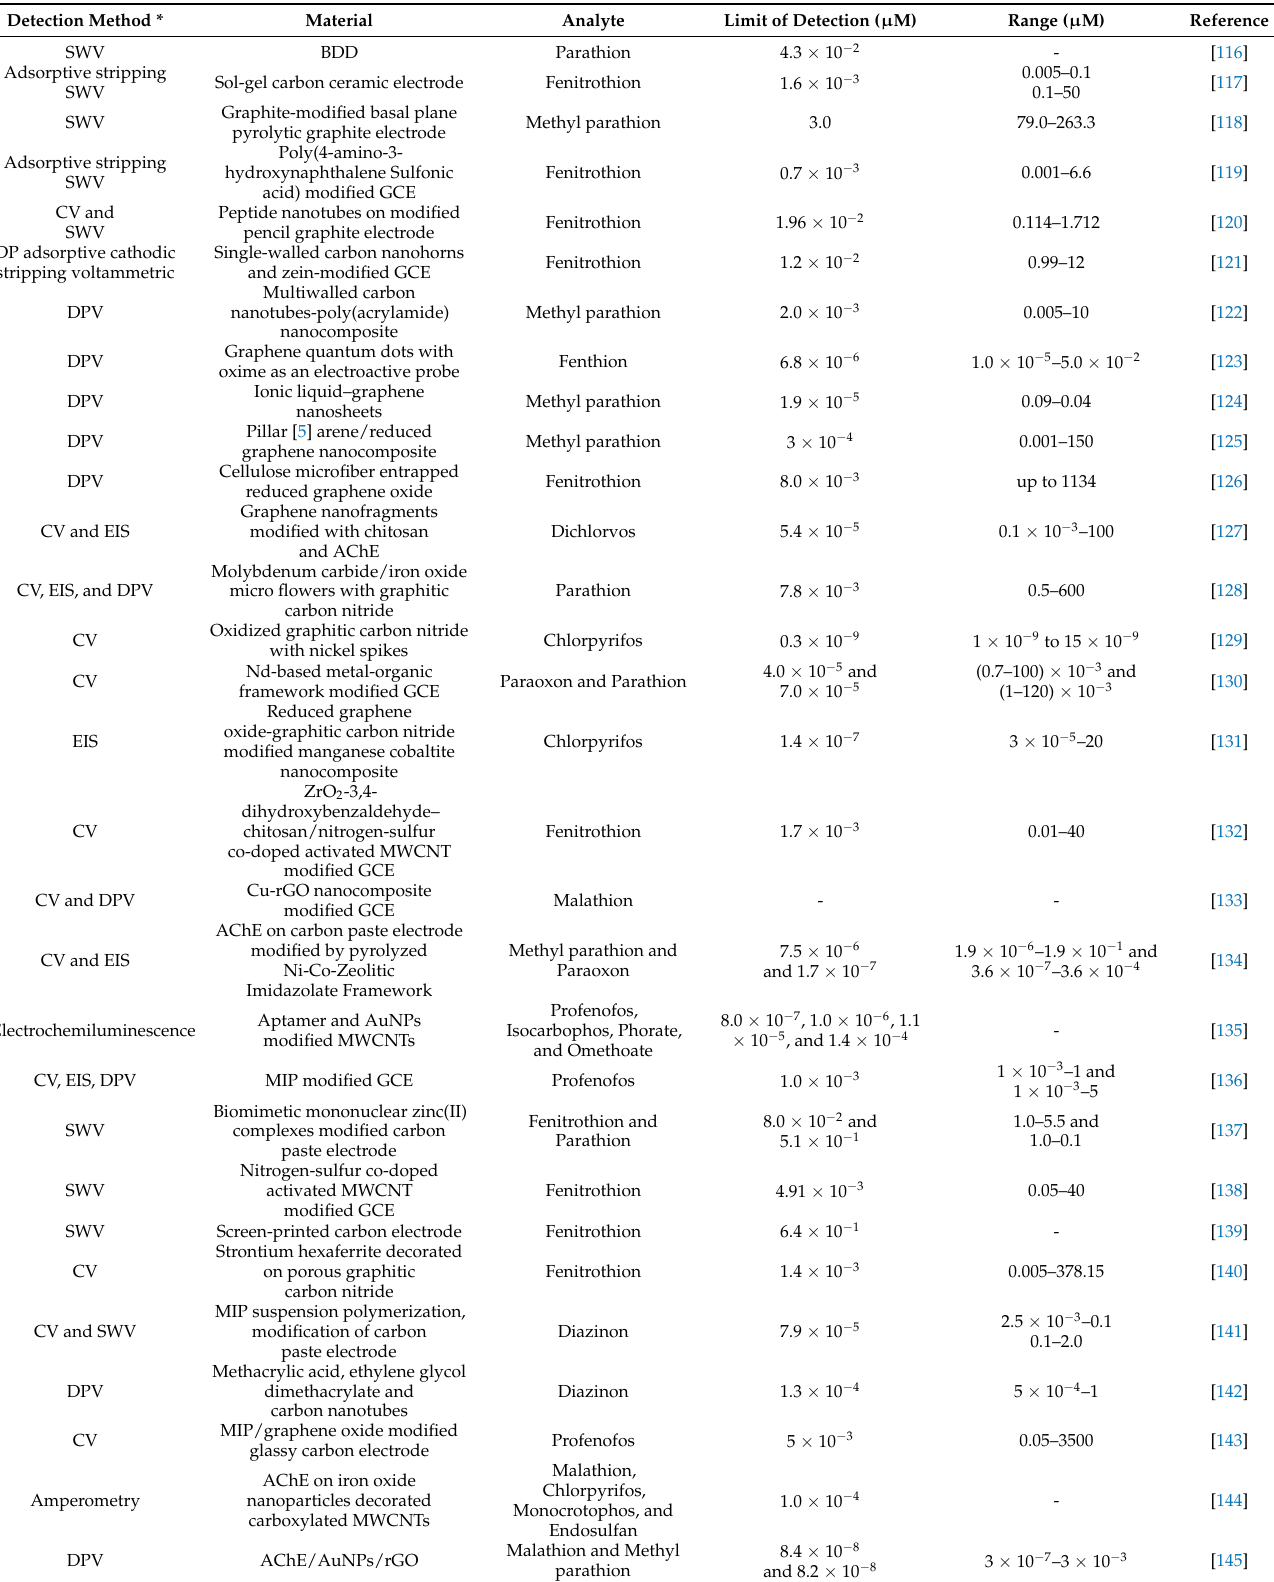
Table 1. Electrochemical sensors for organophosphate detection based on carbon